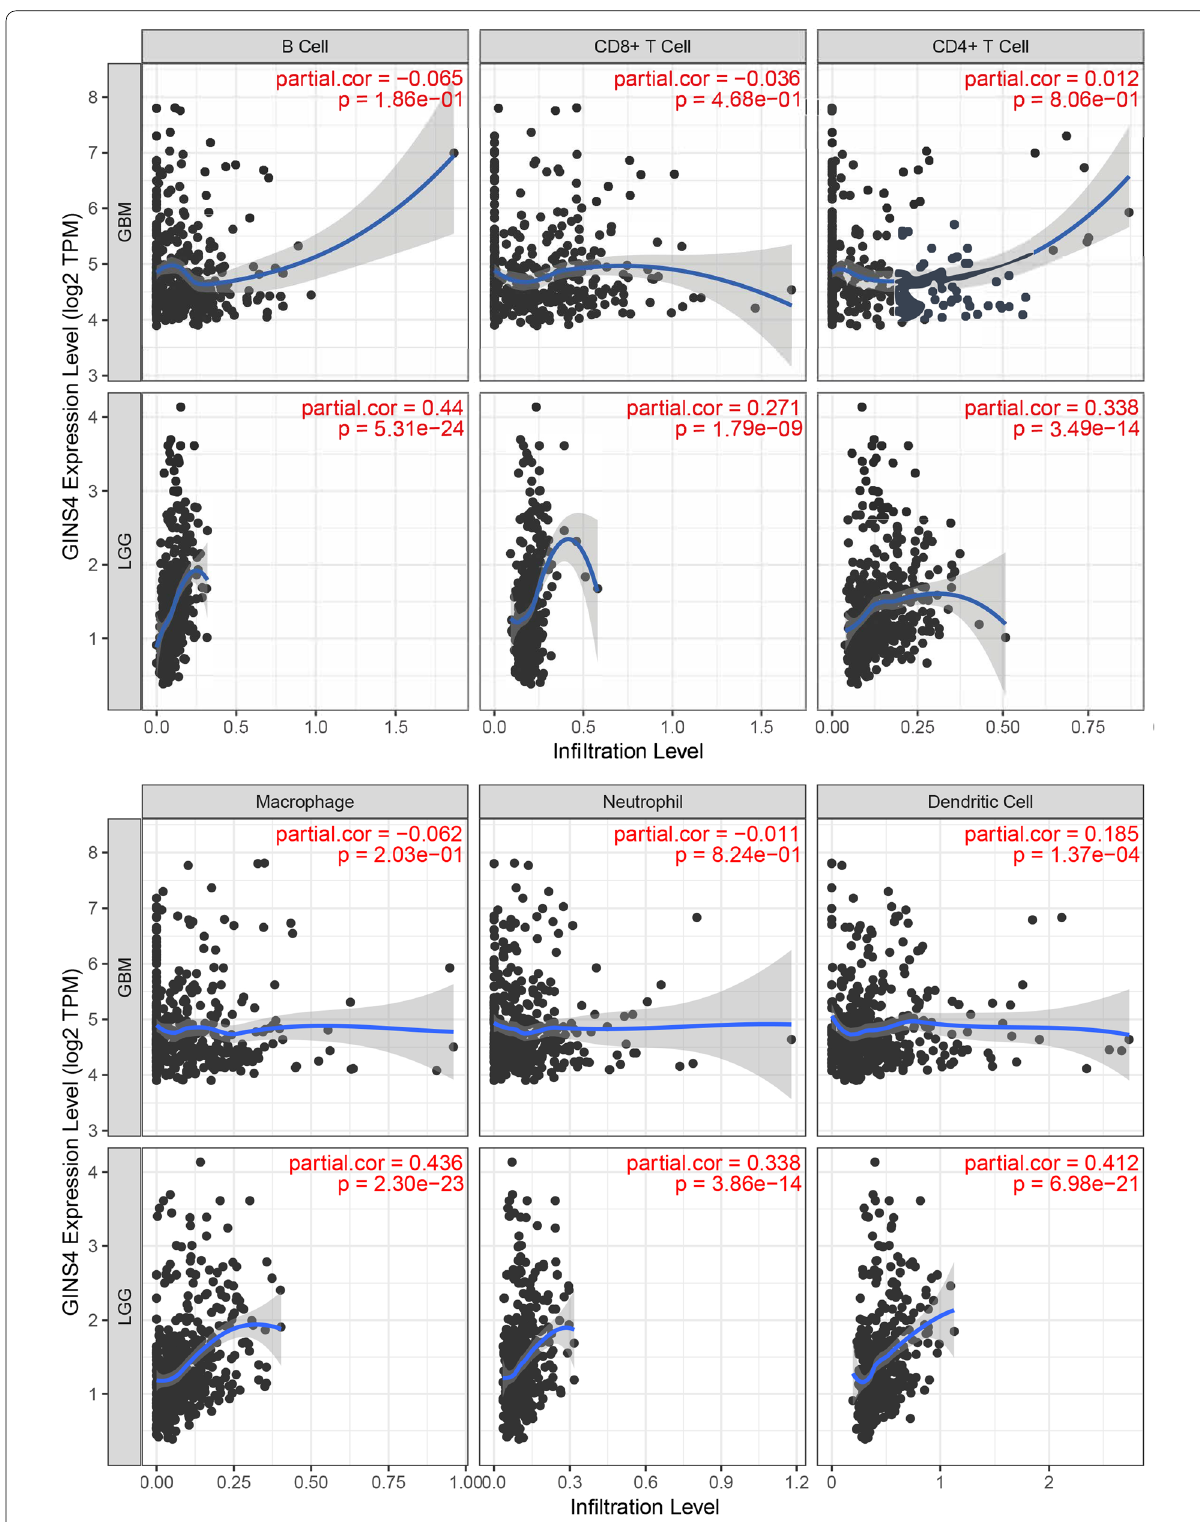
Fig. 10 The expression of GINS4 was associated with immune infiltrating